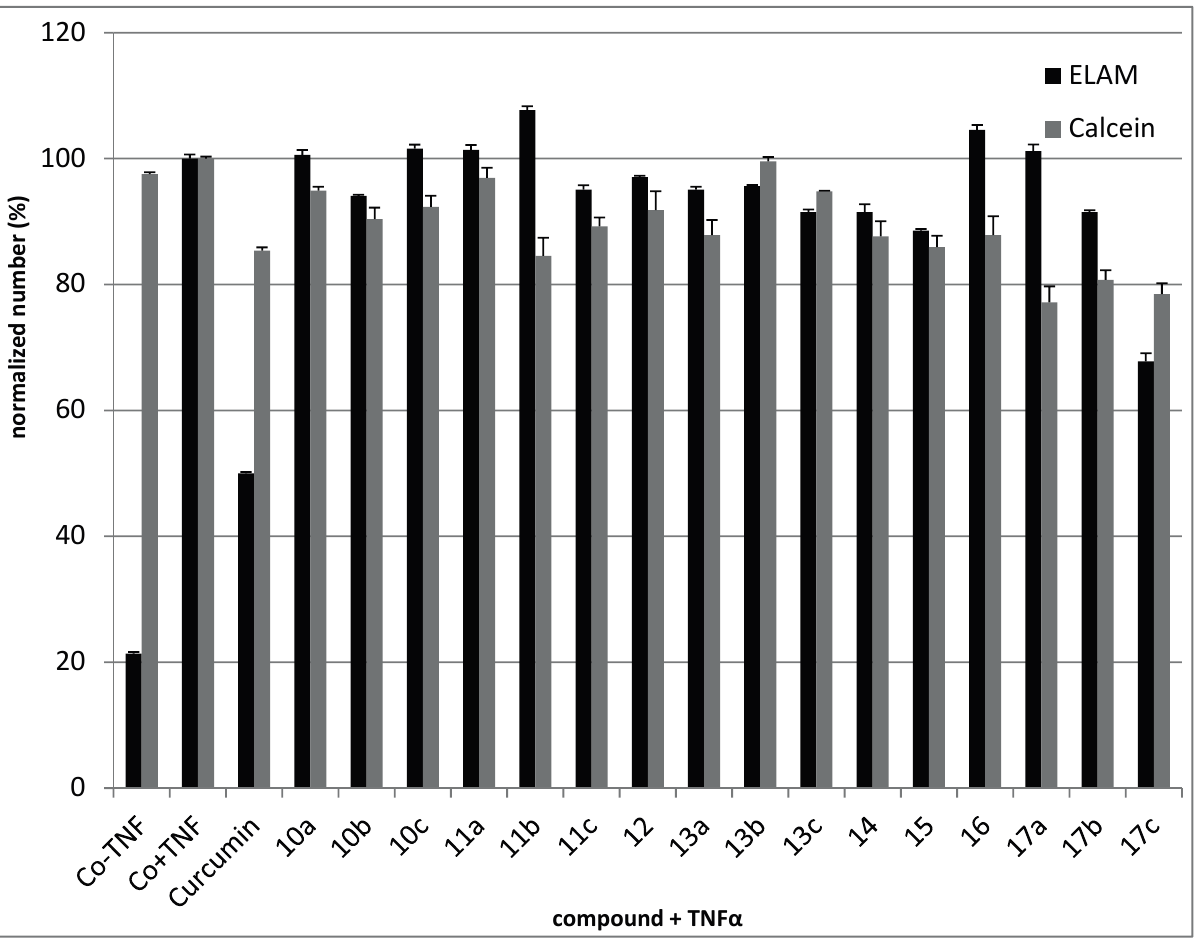
Figure 3. E-Selectin (ELAM) expression in TNF α -induced HUVECs compared to cytotoxicity determined by Calcein AM. Curcumin (10 μ M) was used as a positive control. 1 × 10 4 HUVECs/well were seeded into 96-well plates and grown to confluence. 50 µM of phthalimide derivatives were added 30 min prior to application of 10 ng/mL TNF α for another 4 h. The cells were then fixed and ELAM levels analysed by ELISA. At the same time, the compounds were analysed by Calcein AM assay to monitor non-specific substance